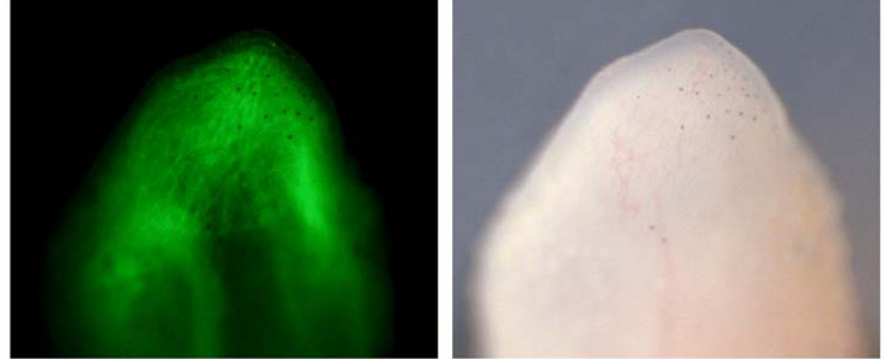
FIGURE 3. A ventral view of the right forelimb blastema of an N-tubulin promoter/GFP transgenic X. laevis froglet at 14 days after amputation. N-tubulin promoter directs reporter gene expression to the neurons[81], and it is noted that numerous GFP-expressing axons are distributed in the blastema. The right panel is a brightfield image of the left panel. Transgenesis was conducted following the procedure described by Kroll and Amaya[81], and the plasmid for transgenesis (N-tubulin promoter/GFP: NBTG) was a kind gift from Enrique Amaya (Gurdon Institute, Cambridge,